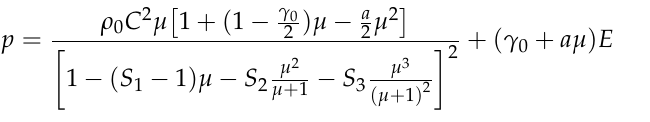
where σ ij is the viscous stress, P is the pressure on the fluid, δ ij is the identity tensor, ρ is . e ij is the rate-of-deformation the fluid density, γ is the dynamic viscosity coefficient, and tensor. The material properties of the mallard bird model are listed in Table 1. Table 1. Null material parameters for the bird [18]. Parameter Value Density 938 kg/m 3 Relative volumetric strain for erosion in tension 1 Relative volumetric strain for erosion in compression 0.8 Table 1. Null material parameters for the bird [18]. Parameter The null material model must be used with an EOS. The EOS is linked to the material’s physical state variables and is often applied in interpreting the properties of fluids and Density solids. According to Reference [28], the Gruneisen EOS and the Tillosten EOS are mainly Relative volumetric strain for erosion in tension used in numerical simulation studies of high-speed collision problems. The Gruneisen Relative volumetric strain for erosion in compression EOS was implemented in this study. There are two forms of the Gruneisen equation, corresponding to two different states of compression and expansion. Pressure for materials in compression is expressed